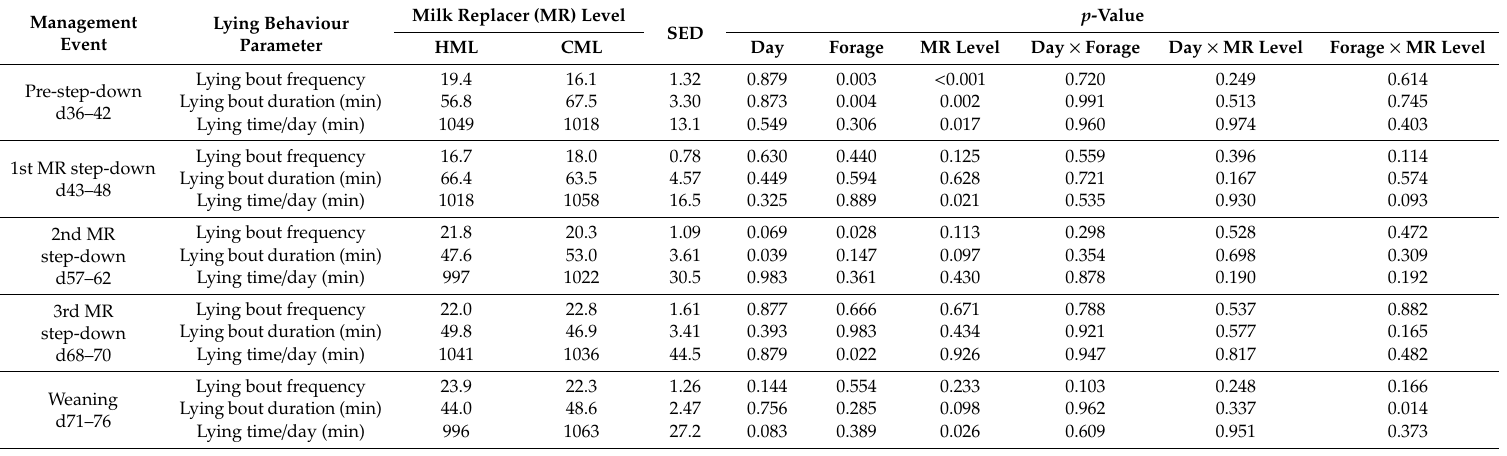
Table 7. Daily lying behaviour of calves managed under di ff erent nutritional regimes throughout the experimental